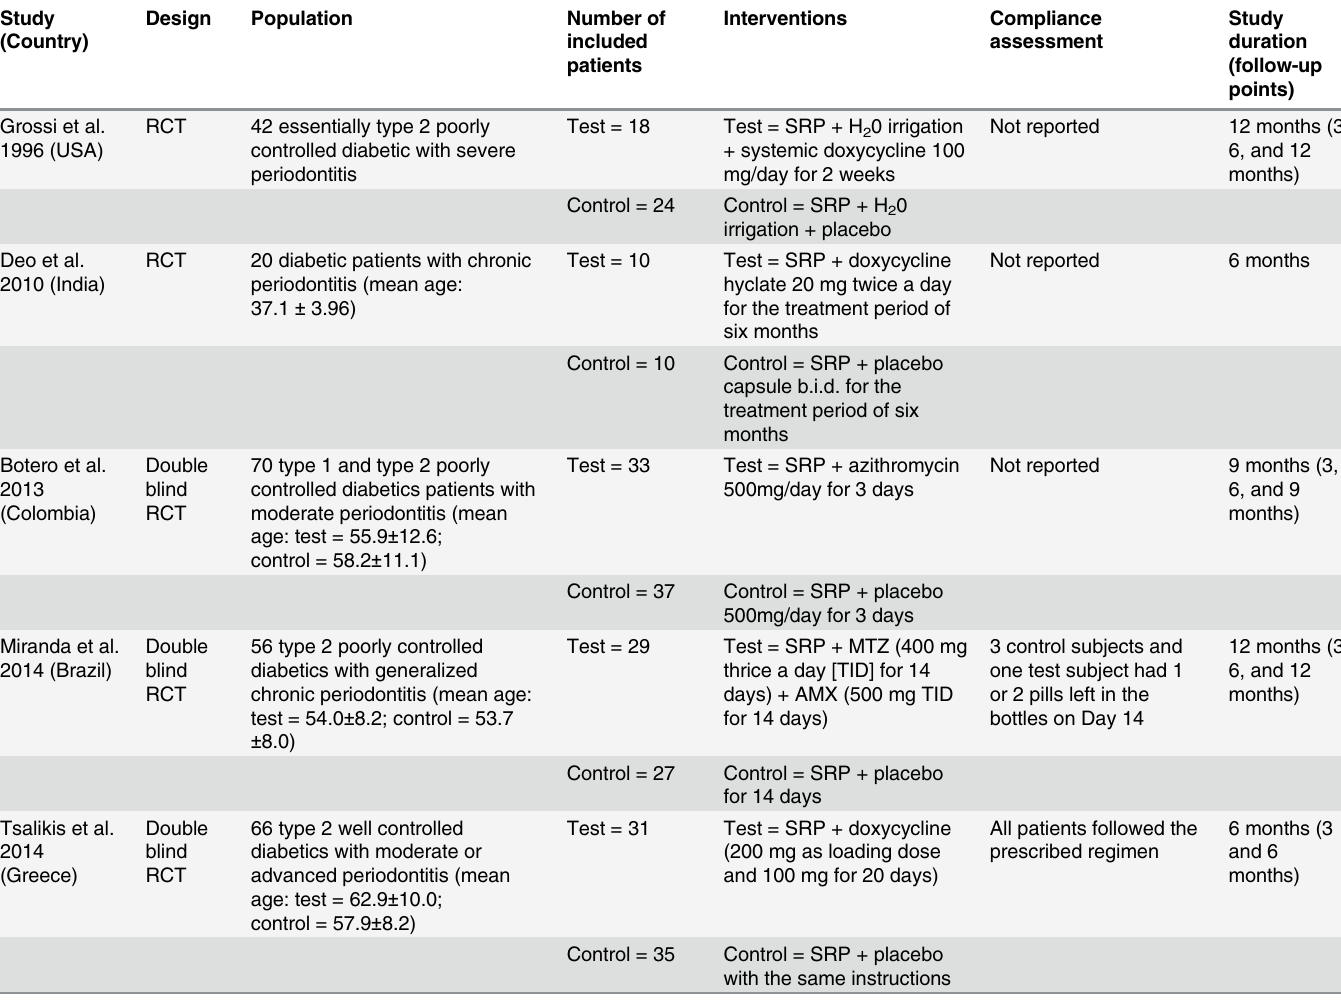
Table 1. General characteristics of included studies.